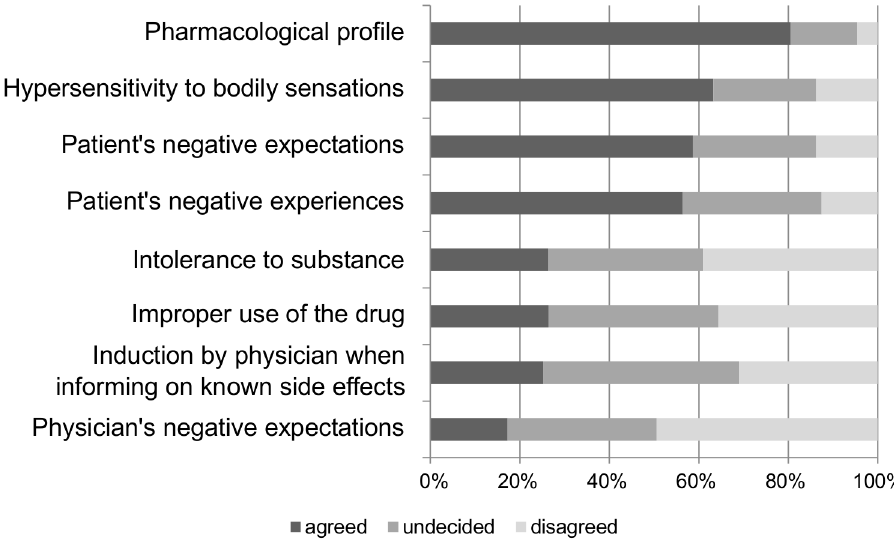
Fig 2. Physicians’ agreement to different explanatory models for the occurrence of side effectsfrom antidepressants. Depictedis the percentageof participants that agreed, disagreedor were undecided whetherto endorsethe suggestedreasons for the occurrence of side effects in